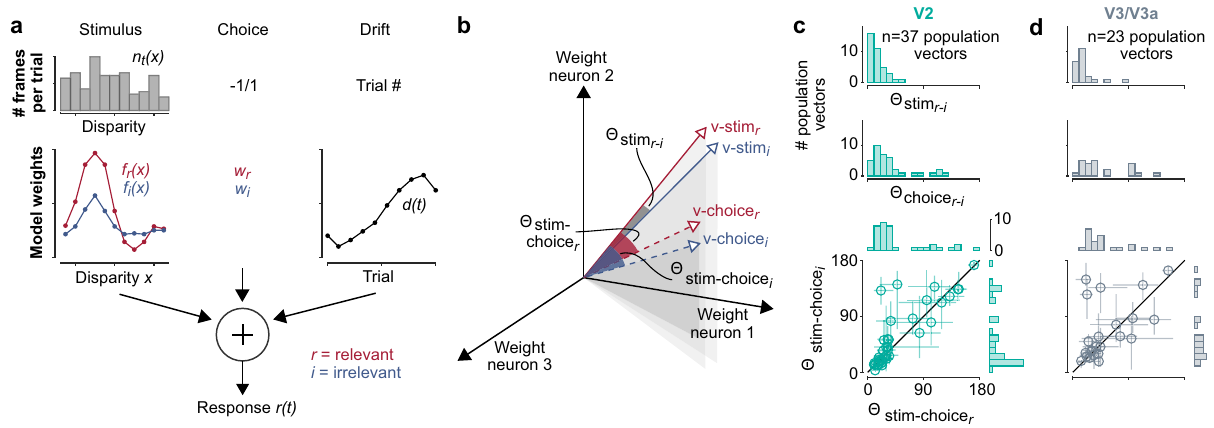
Fig. 4 Stimulus and choice alignment of the population response in visual cortex. a The encoding model predicts the spike count in a trial from the stimulus-driven response based on its disparity tuning curve and the disparities presented in that trial (left), the choice during that trial (middle), and a drift term to fi t any non-stationarity in the recording over time (right). b The stimulus- or choice-driven patterns of neural activity across the recorded neurons can be represented as population vector, with each dimension corresponding to a given neuron ’ s stimulus- or choice-driven weight estimated from the encoding model. The patterns of activity can then be compared as an angle between the population vectors. c , d Results for populations in V2 and V3/V3a. Top: The population vectors for the relevant and irrelevant stimulus are well aligned across sessions. Middle: the population vectors for the choices when the stimulus was relevant or irrelevant are broadly aligned. Bottom: The angles between the population vectors for the relevant stimulus (v-stimr) and choice (v-choicer or v-choicei) are correlated ( r = 0.86, p = 10 − 10 , n = 37 sessions for V2; r = 0.51, p = 0.01, n = 23 sessions for V3/V3a, two-sided Spearman ’ s rank correlation; error bars are 90% con fi dence intervals around the median angle, by